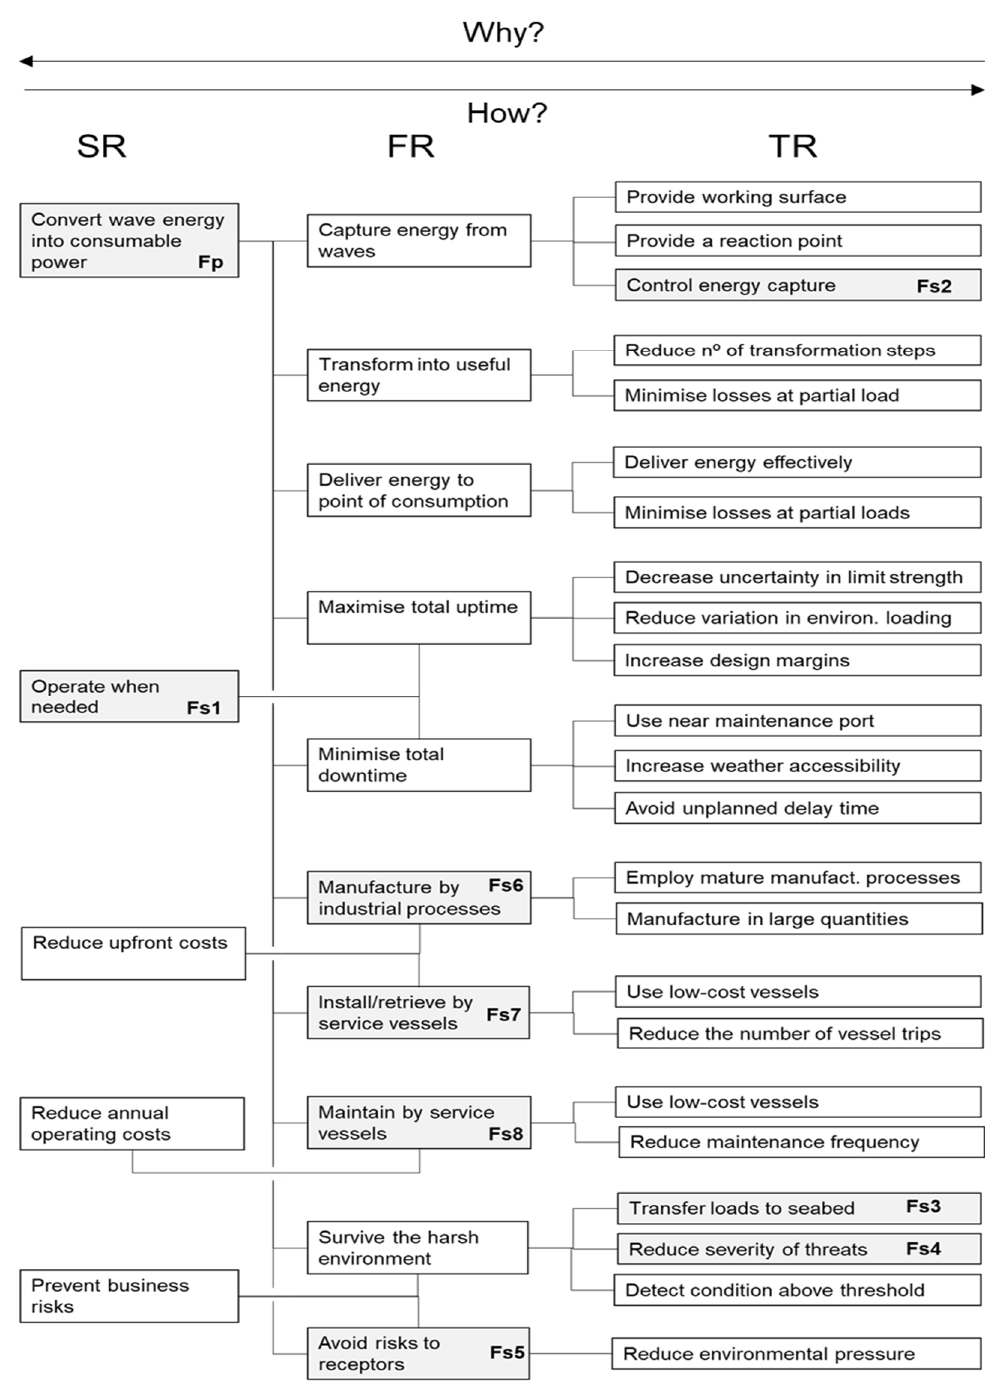
Figure 9. FAST diagram for the wave energy system.